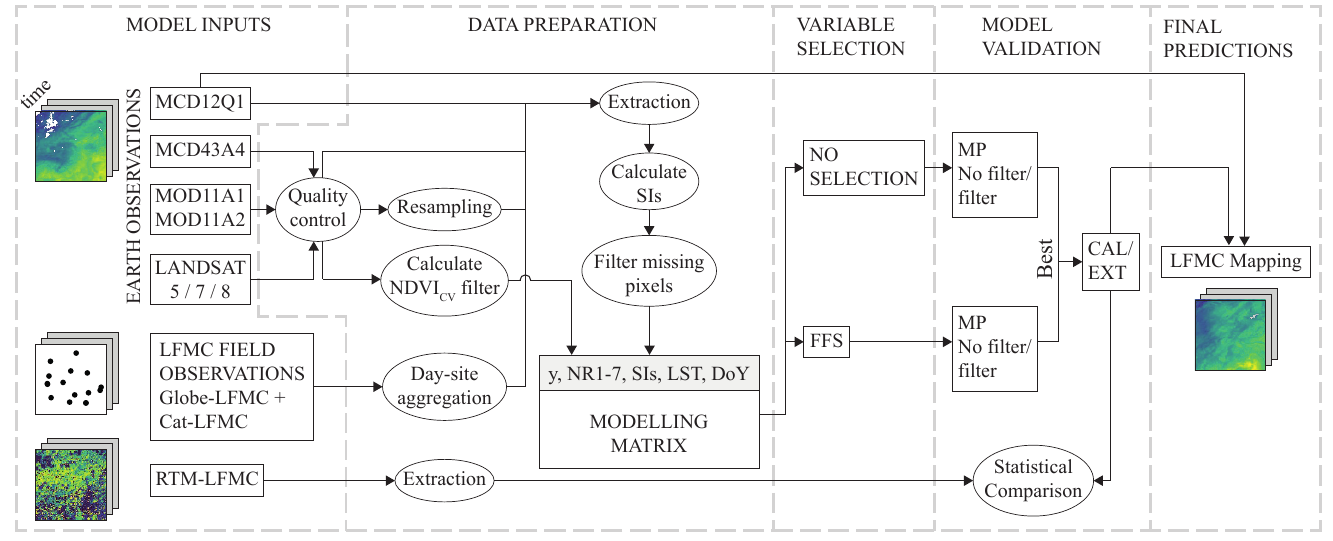
Figure 1. Overview of the pre-processing, modelling, and analysis steps.